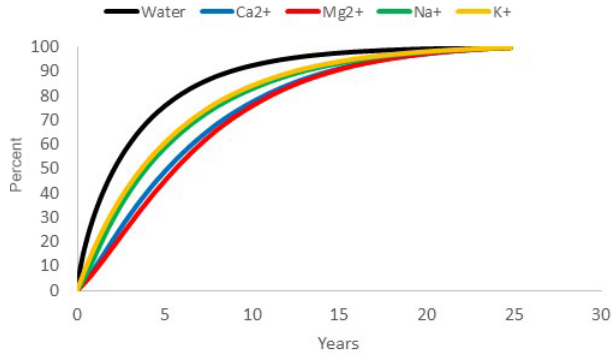
Figure 9. Cumulative water transit time distribution (black) of the study hillslope, and the distribution of the “age” of the water carry- ing each of the base cations according to model